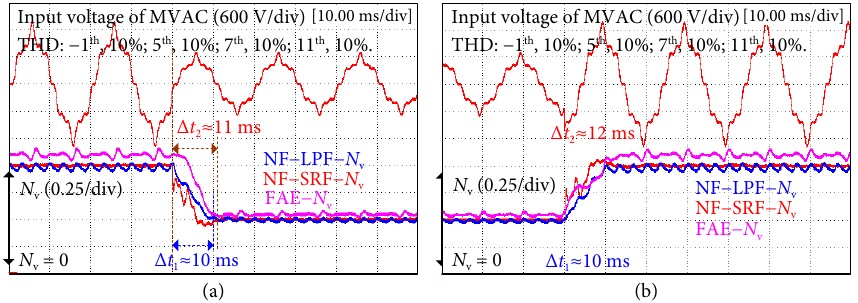
Fig. 14 Experimental results when the voltage sag depth is 0.5, and the THDs of 1th, 5th, 7th, and 11th components are all 10%. (a) Sag transition. (b) Recovery transition.